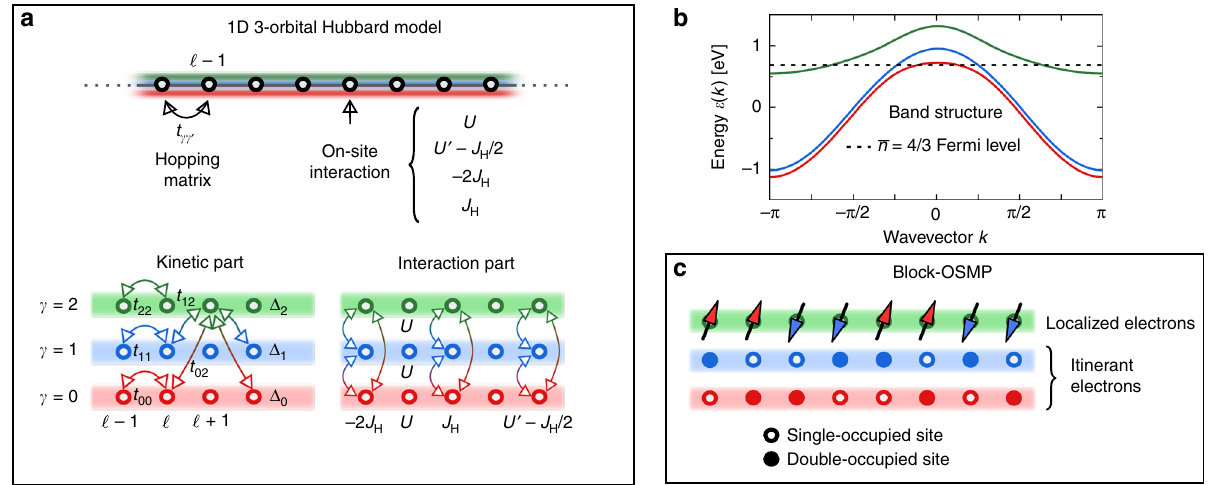
Fig. 1 Schematic representation of the Hamiltonian. a Three-orbital Hubbard model on a one-dimensional lattice geometry (see text for details). b Band structure of Hamiltonian Eq. (1). Note that due to the hybridization t γγ ′ ≠ 0 for γ ≠ γ ′ , the band numbers do not correspond directly to the orbital numbers. c Schematic representation of the block orbital-selective Mott phase. The pattern of single and double occupied sites in the itinerant electrons is meant to be random, representing pictorially the not-localized nature of those